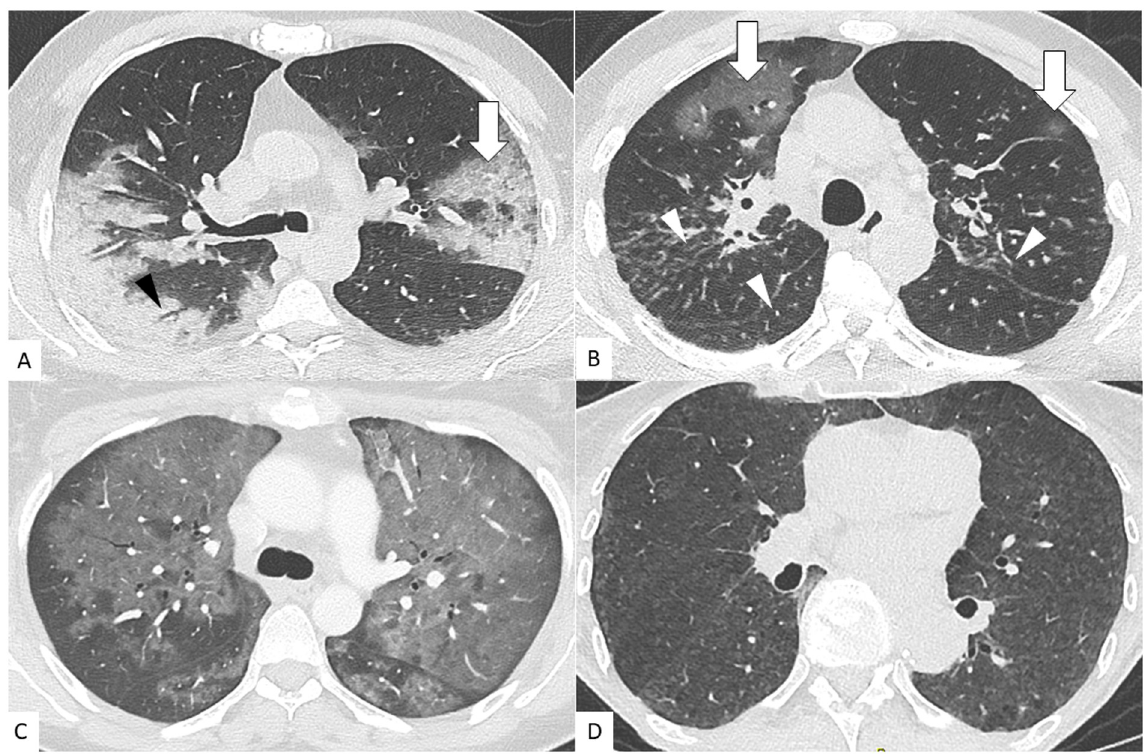
Fig 3. Lung CT patterns found in patients with and without COVID-19 pneumonia. A) Unenhanced chest CT images of a 62-year-old man with fever and dyspnea revealing one of the typical CT patterns for COVID-19 pneumonia. Axial images show ground glass opacities, crazy paving pattern (arrows) and consolidation with air bronchogramm (arrowhead) mostly distributed in subpleural regions and involving all lobes. RT-PCR here was positive (suggesting true positive diagnosis of CT). B) Unenhanced chest CT images of a 56-year-old man with COVID-19 pneumonia and sarcoidosis. Axial CT images revealed bilateral ground glass opacities (arrows) and perilymphatic irregular nodular thickening in an upper/mid lung distribution (arrowheads). RT PCR was positive (suggesting true positive diagnosis of CT). C) Enhanced chest CT images of a 37-year-old woman with dyspnea and fever revealing Pneumocystis Jiroveci infection. Axial CT images shows central diffuse GGO bilateral falsely considered suggesting of COVID-19. RT-PCR was here negative (suggesting false positive diagnosis of CT). D) Unenhanced chest CT images of a 67-year-old woman with dyspnea for few days revealing a hypersensitivity pneumonitis. Axial CT images shows homogeneous GGO bilateral and symmetric with a bronchovascular distribution. CT was considered suggesting another diagnosis than COVID-19. RT-PCR was here negative (suggesting true negative diagnosis of CT).